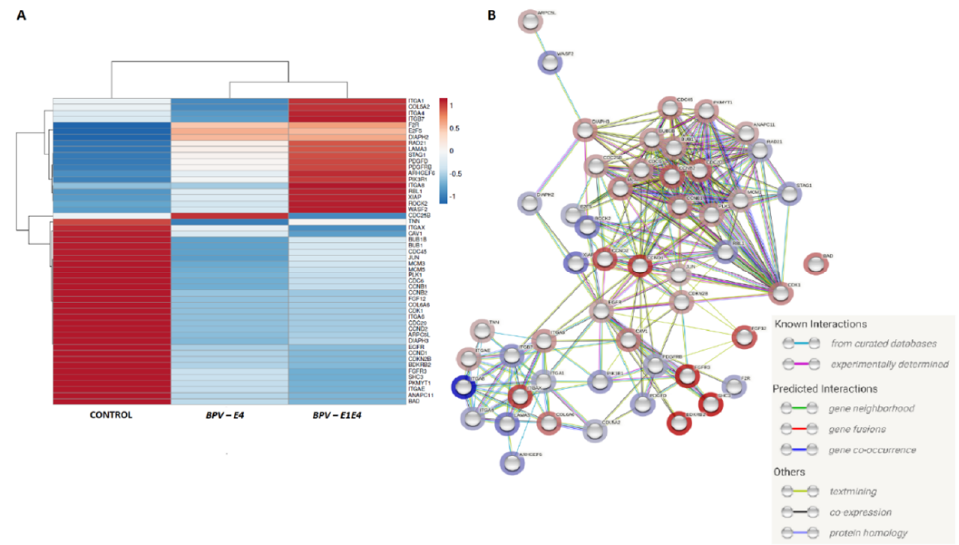
Figure 6. The interactions between 51 genes identified in both BPV-E4 and BPV-E1^E4 transgenic cells undergoing sarcoid-dependent neoplastic transformation, and belonged to molecular pathways related to procancerous intracellular conversion: ( A ) the heatmap of the mean expression for groups (R package [23]); ( B ) the interaction between identified DEGs with FC direction marked (String software [24]).